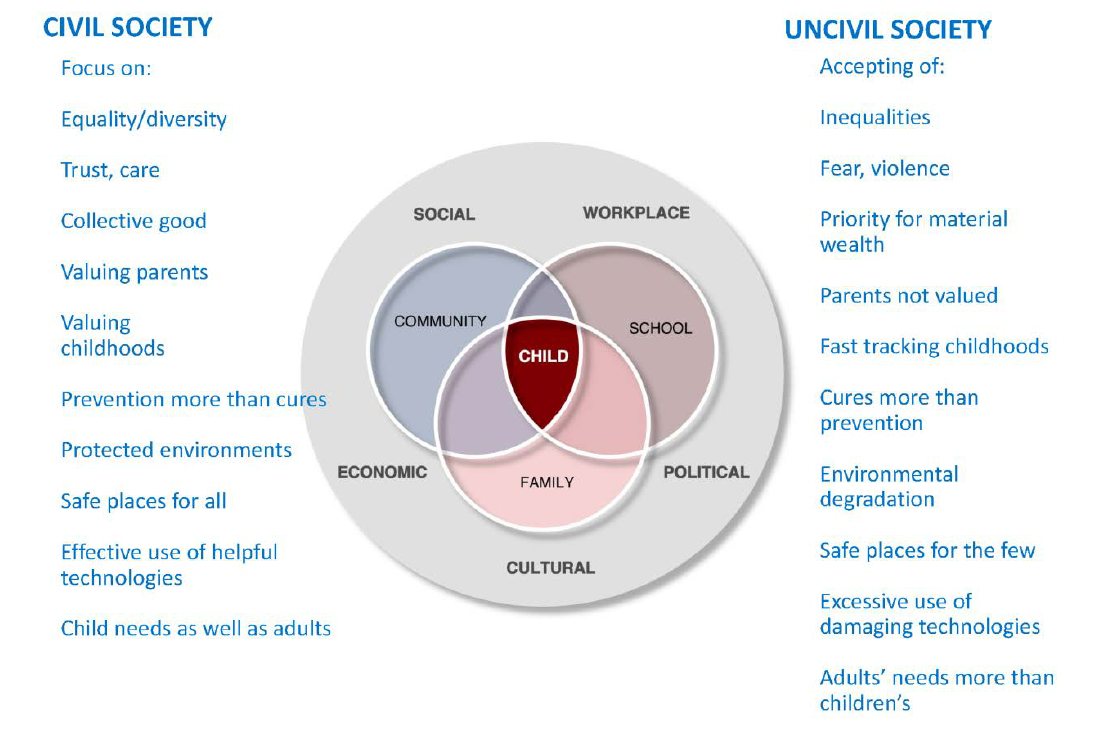
Figure 5. Ecological factors in Child Wellbeing